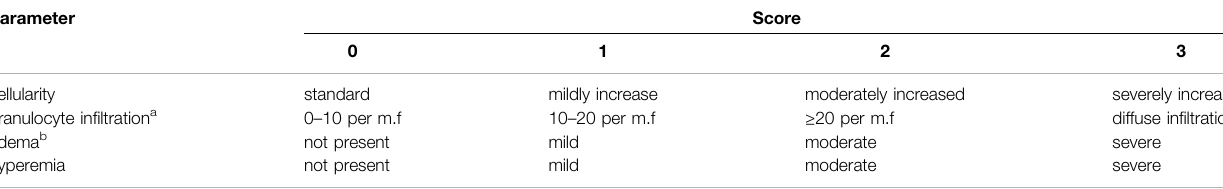
TABLE 3 | A semiquantitative score of histopathological changes in the intestine.